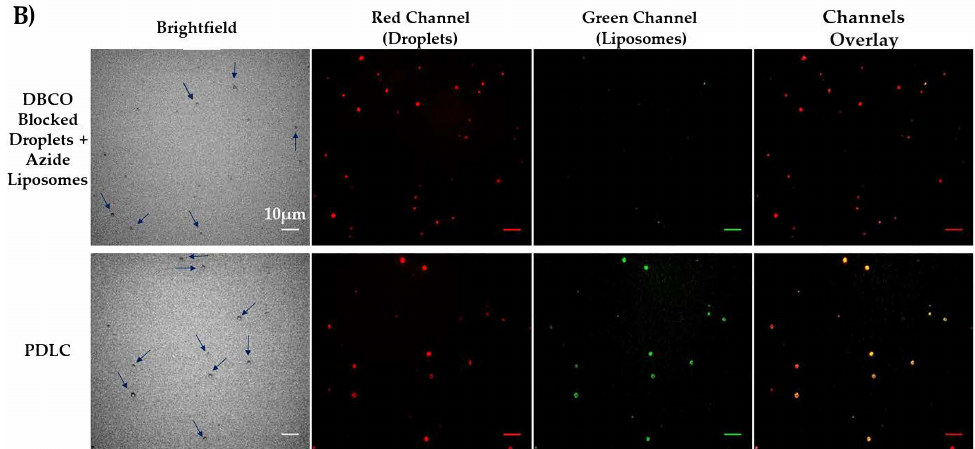
Figure 2. ( A ) Schematic figure for DBCO-Azide click chemistry. ( B ) Fluorescent Microscopy of PDLCs after washing the unbound liposomes. Phase changeable droplets are dyed with DiD (red) and liposomes are dyed with DiO (green). There are no liposomes bound to the droplets in the top row since DBCO binding groups on droplets’ shell in this sample are blocked with sodium azide. Colocalization of green liposomes and red droplets (yellow) in the PDLC sample shows the clustering of droplets and liposomes. All scale bars show 10 µ